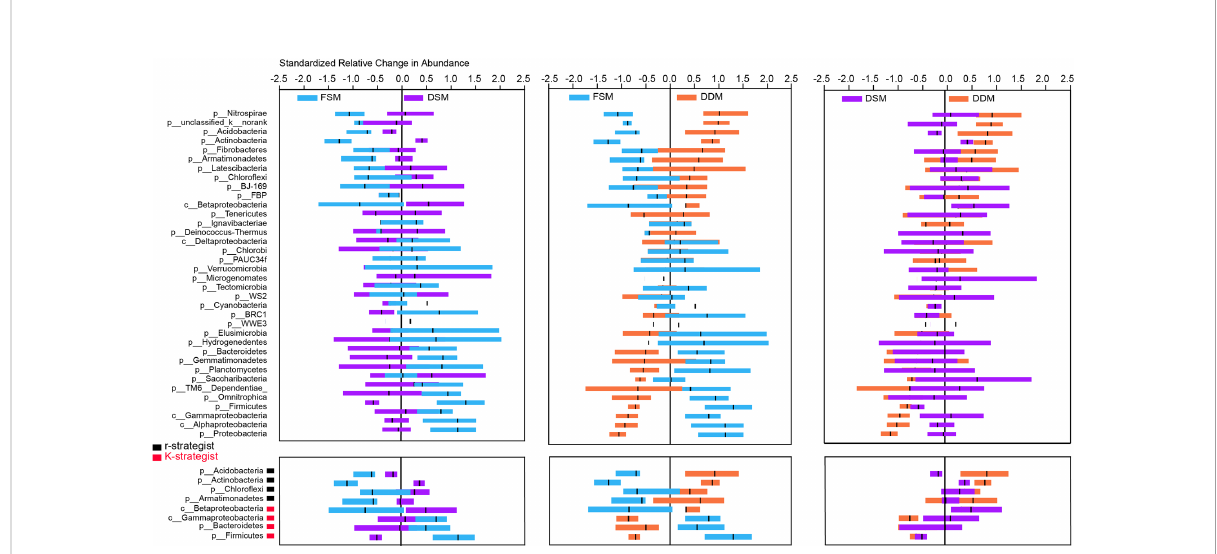
FIGURE 2 Relative changes (z-transformed) in the abundance of bacterial phyla (upper panel) as well as the major K-strategist and r-strategist groups (lower panel). K-strategist groups: Acidobacteria , Actinobacteria , Chloro fl exi ; r-strategist groups: Betaproteobacteria , Gammaproteobacteria , Bacteroidetes , Firmicutes